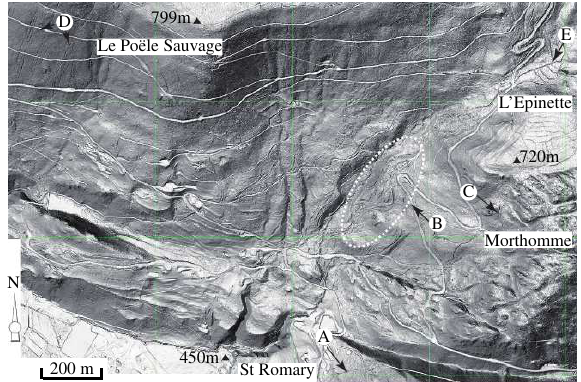
Figure 9. Location of studied hollow structures.